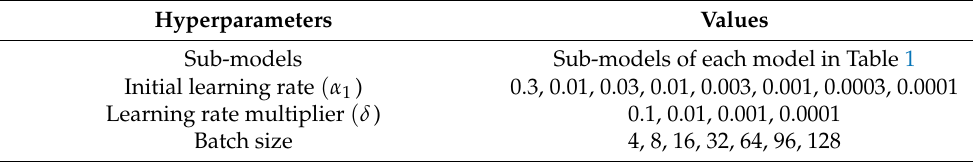
Table 5. Search space for the hyperparameter tuning.